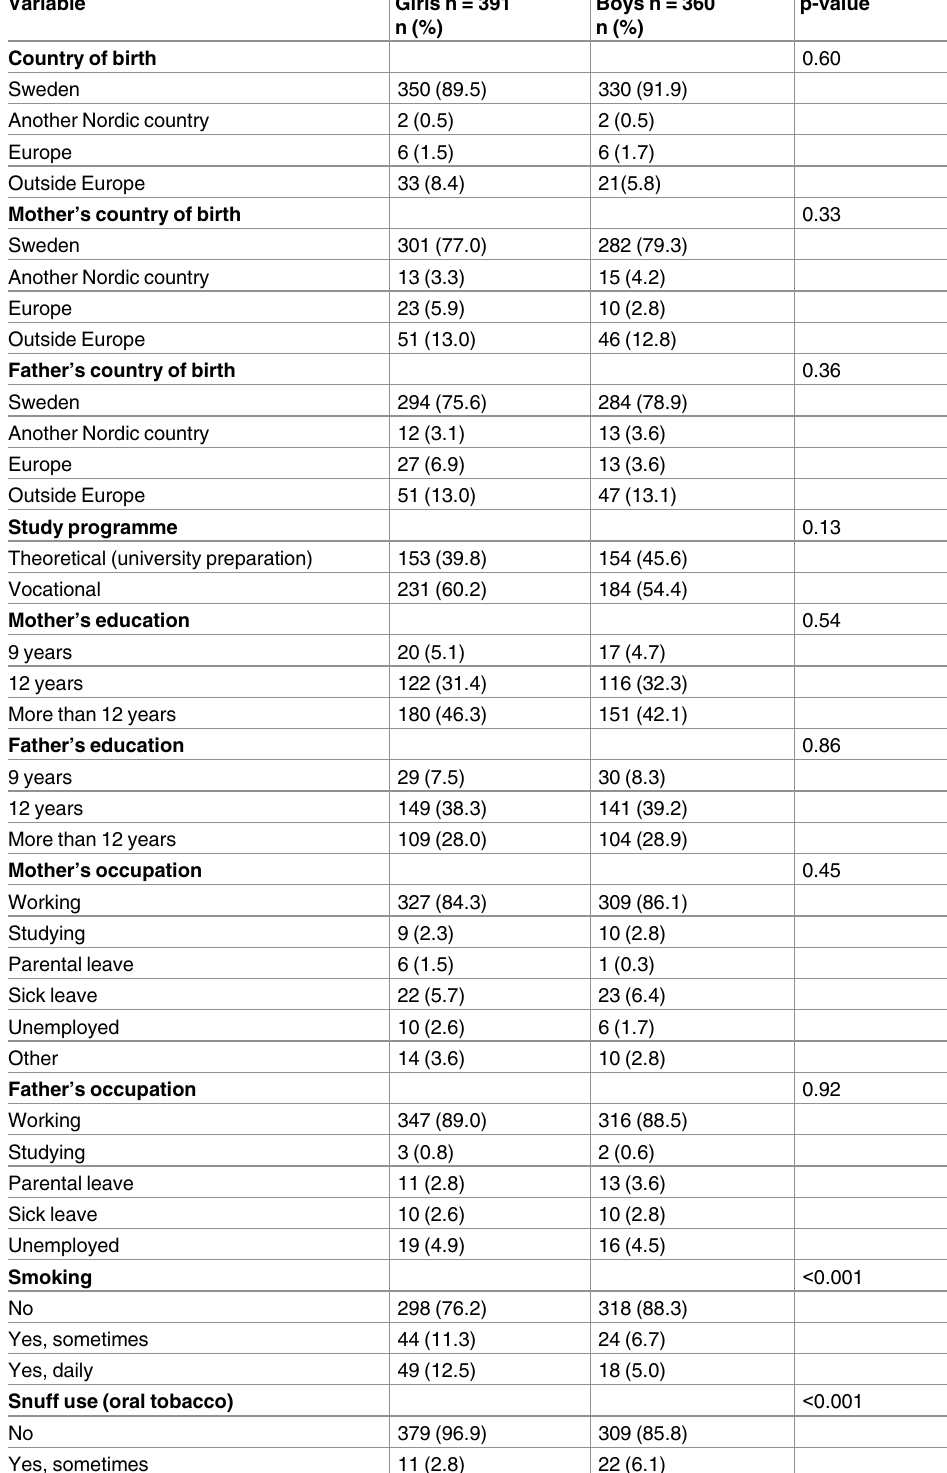
Table 2. Characteristics of the participants and their